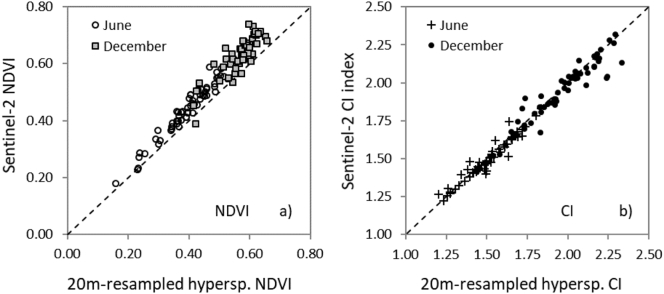
Comparisons carried out for NDVI (a) and CI (b) indices from spatially-resampled hyperspectral vs. Sentinel-2A data for all sites and dates used in this study.